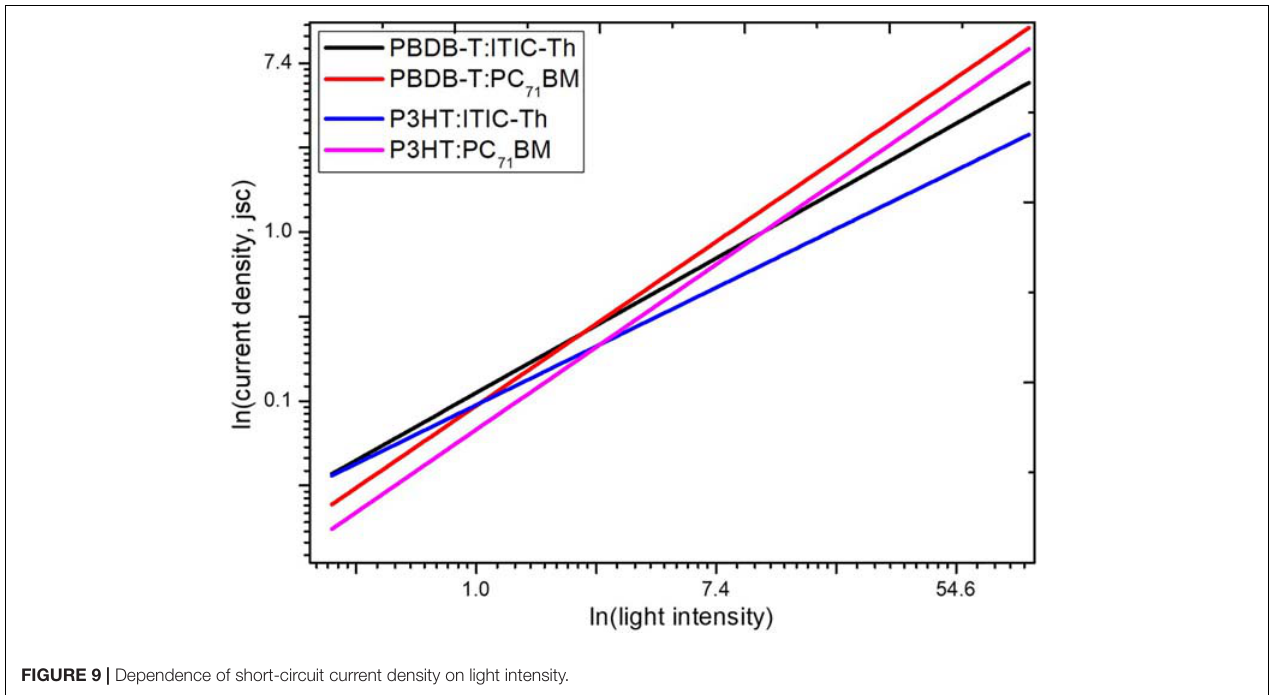
FIGURE 9 | Dependence of short-circuit current density on light intensity.